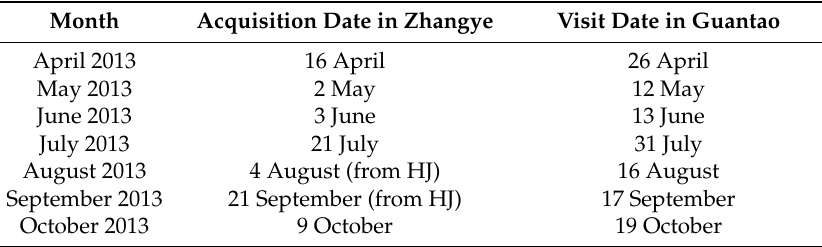
Table 4. Acquisition date of 30-m